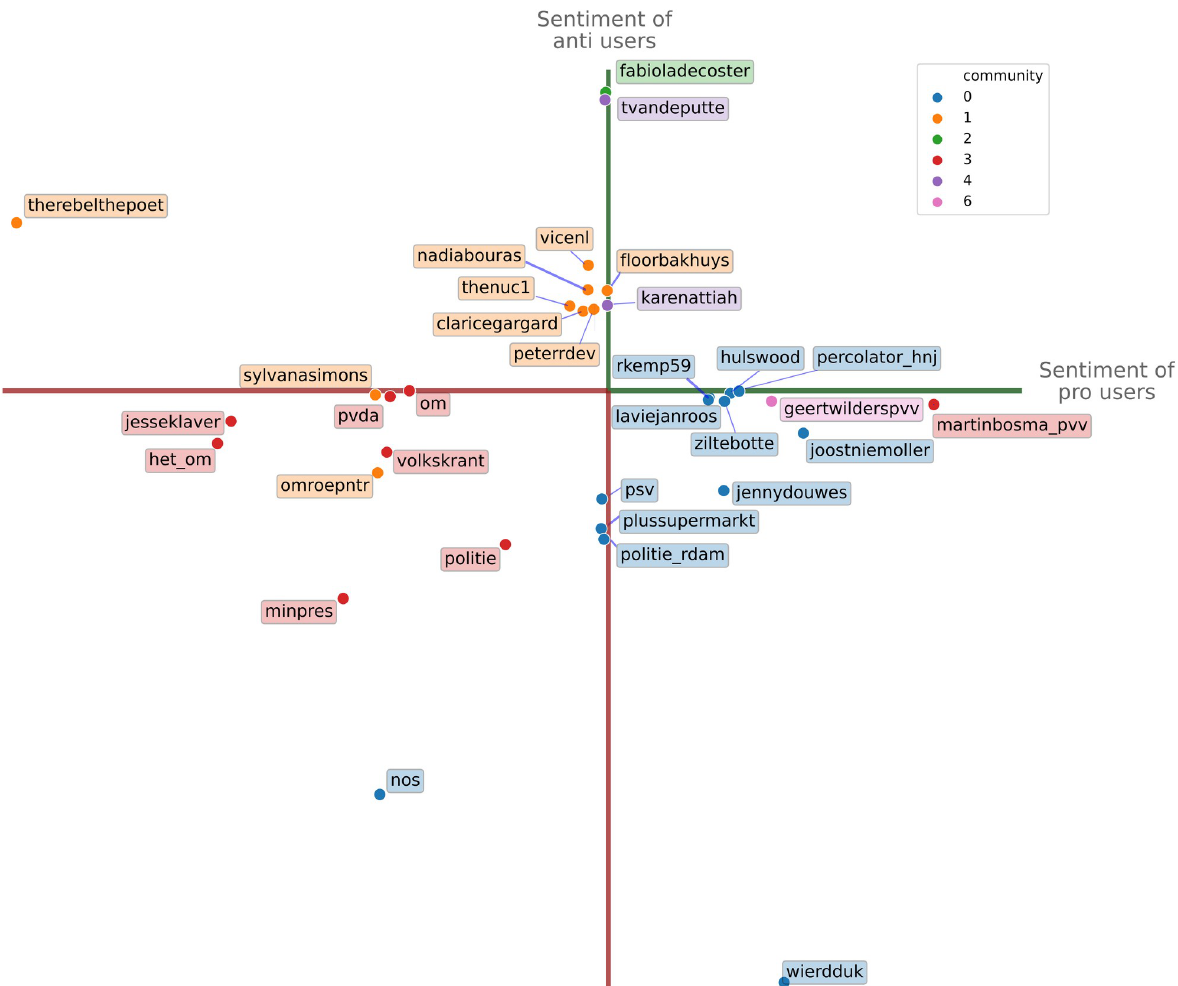
Fig 11. User typology of the Black Pete debate. Positions of top users in the Twitter Black Pete debate, as defined by the way users of both sides (pro and anti) reference the users. The x-axis and y-axis represent the average sentiment of pro and anti-users respectively, in which the positive (negative) number of edges to each user is normalized by the total positive (negative) edges of pro (for x-axis) and anti (for y-axis) users in total. Users are colored by their respective communities in the signed network.